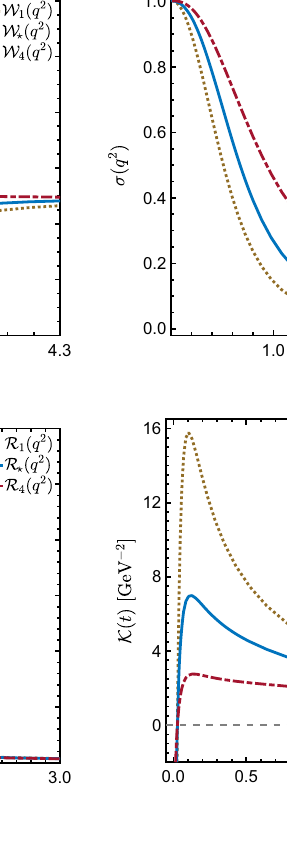
The only element from the two-point sector that enters in these sum rules is the ghost dressing function; its